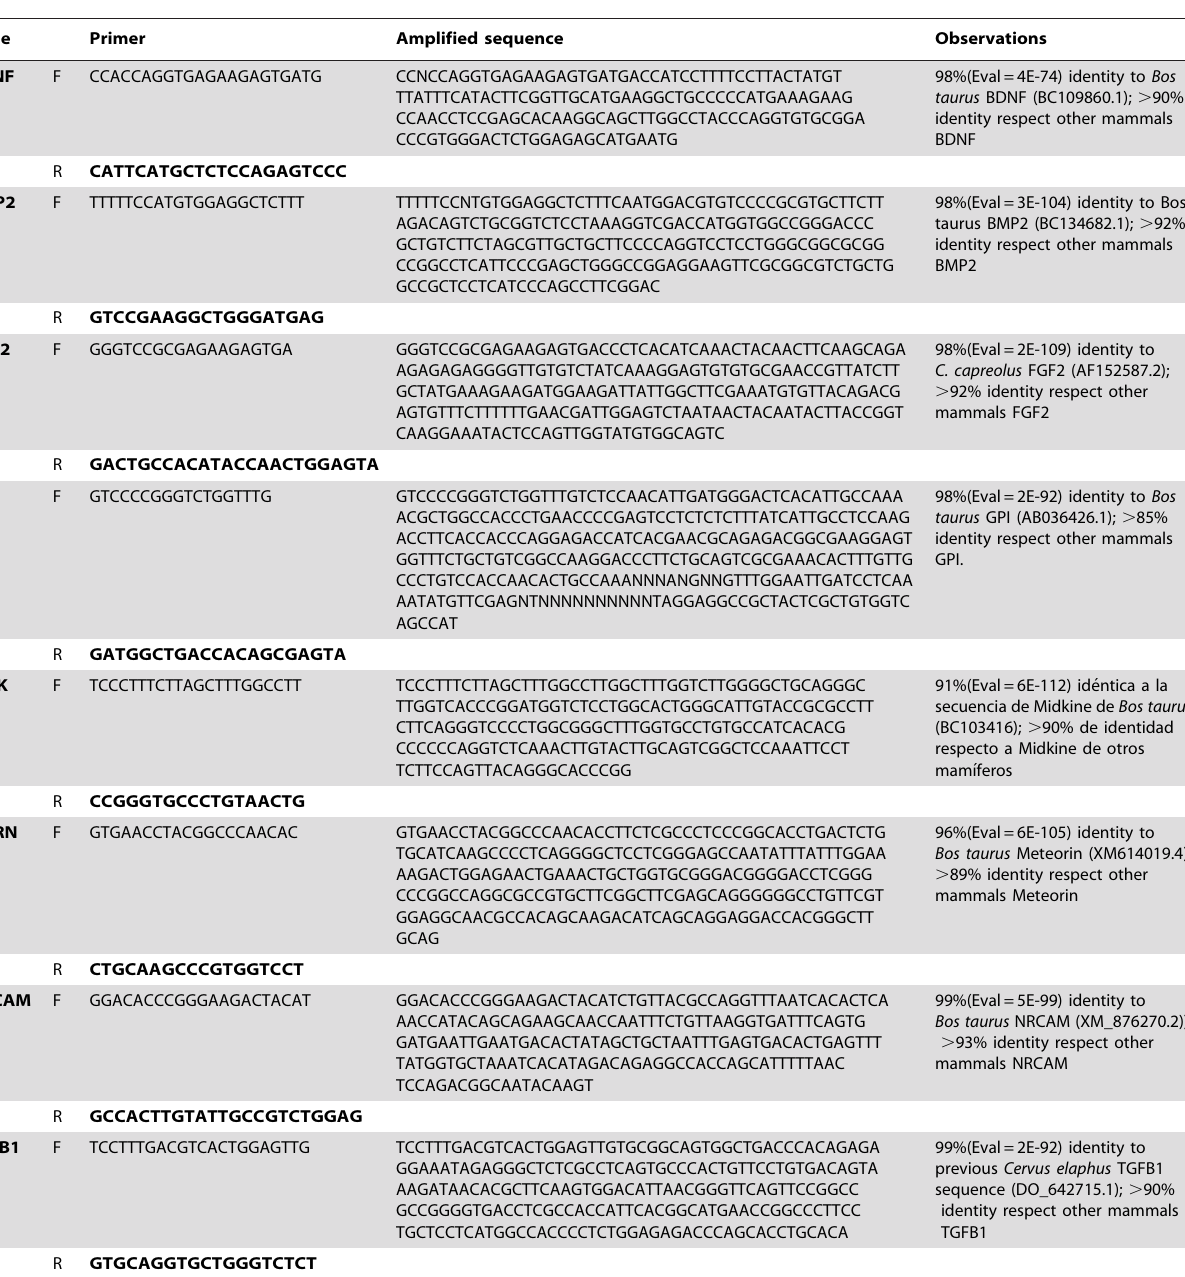
Table 5. Sequencing of axon growth